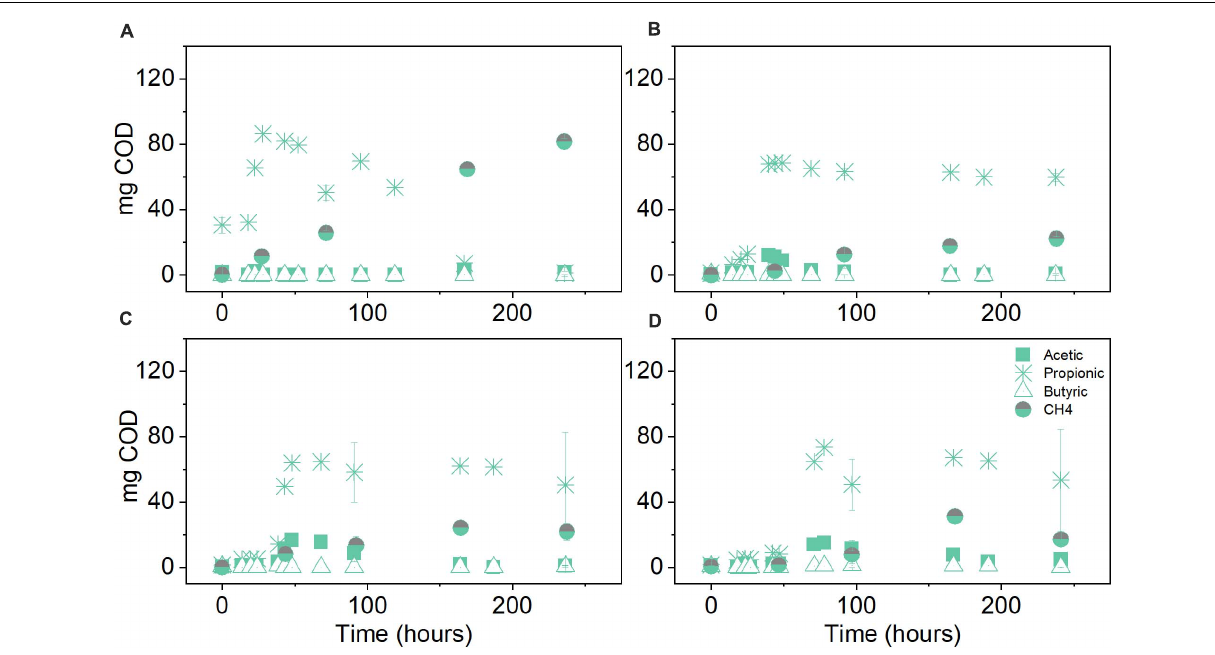
FIGURE 7 | Volatile fatty acid and CH 4 production (mg COD) over time for the glycerol conversion experiments using original inoculum at initial pCO 2 of (A) 0.3 bar, (B) 3 bar, (C) 5 bar, and (D) 8 bar. Pressure corresponds to initial values before equilibrium. Data points represent experimental data. Bars represent the standard deviation of three biological replicates measured at the beginning, middle and end of the